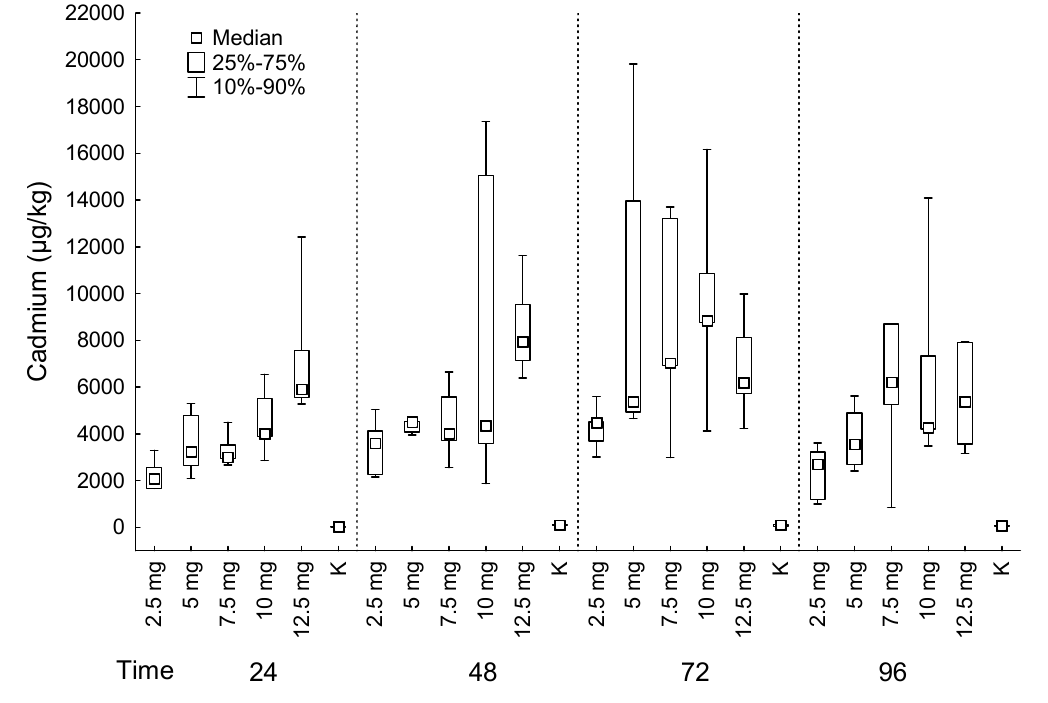
Figure 4. KIDNEY : Cadmium ( μ g/kg) in fish grouped according the exposition to cadmium chloride (mg/L) (K–control